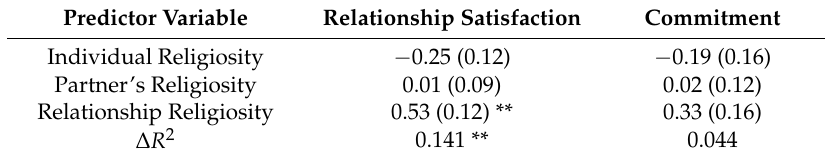
Table 5. Hierarchical regression analyses examining religiosity for relationship quality ( N =